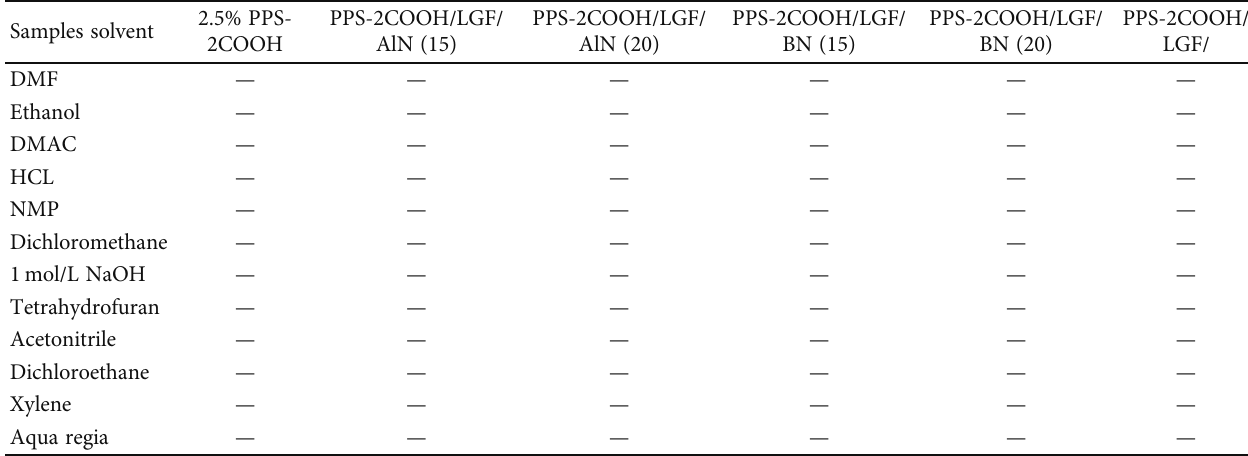
Table 3: Solubility of PPS-2COOH and its composites.